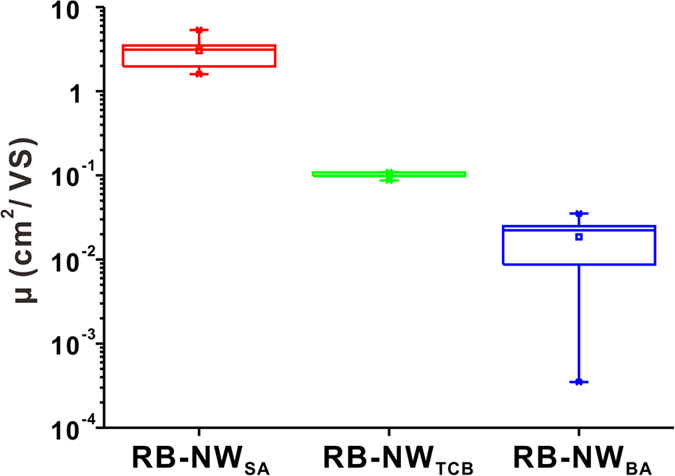
Average field effect hole mobility of RB-NWBA, RB-NWTCB, and RB-NWSA.